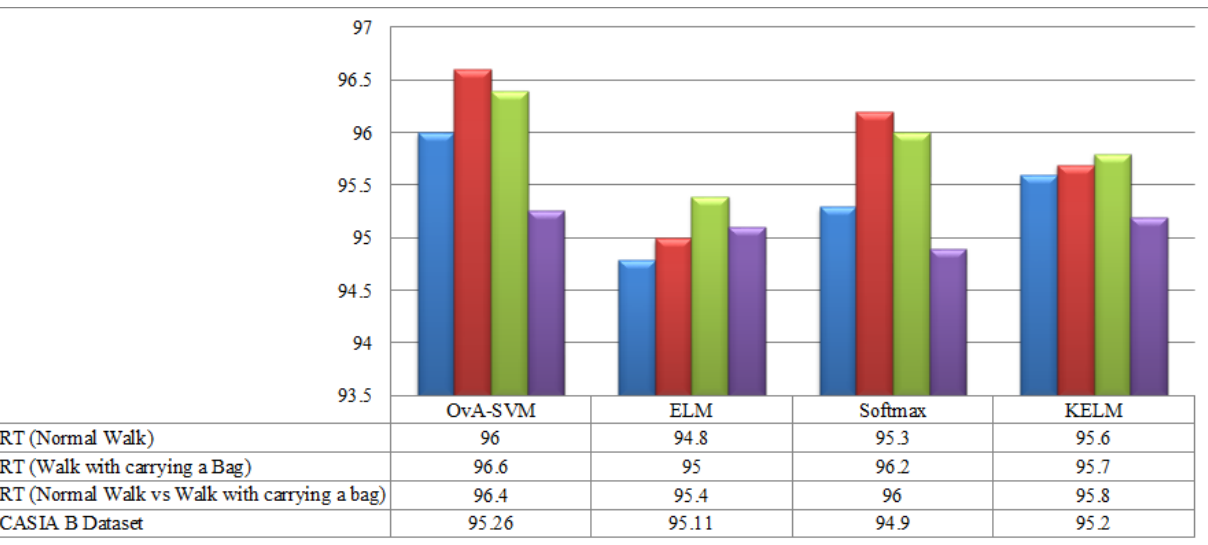
Figure 19. Comparison of OvS-SVM classifier with other classification algorithms for gait recognition .